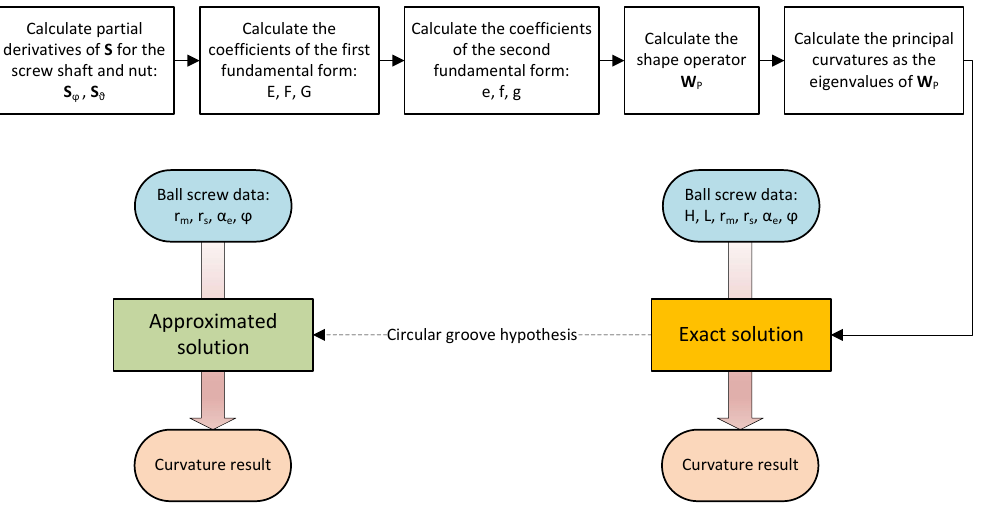
Figure 4. Procedure for obtaining the analytical and approximated